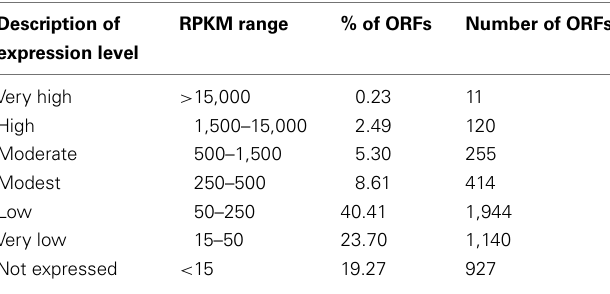
Table 1 | Classification of gene expression level based on replicate averaged